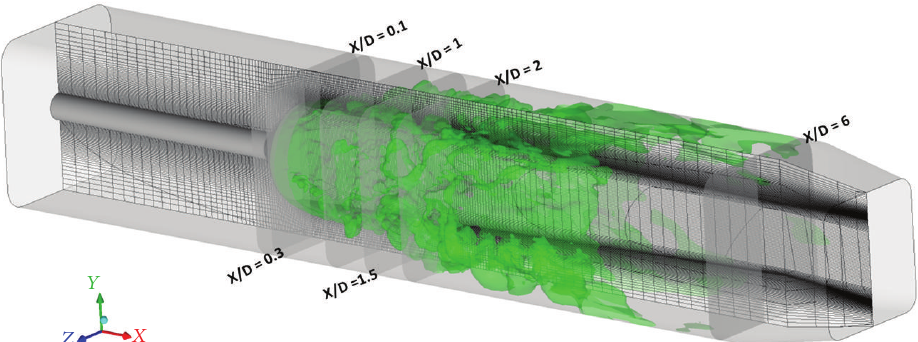
Figure 5: Simulated domain, sample planes, and a mesh